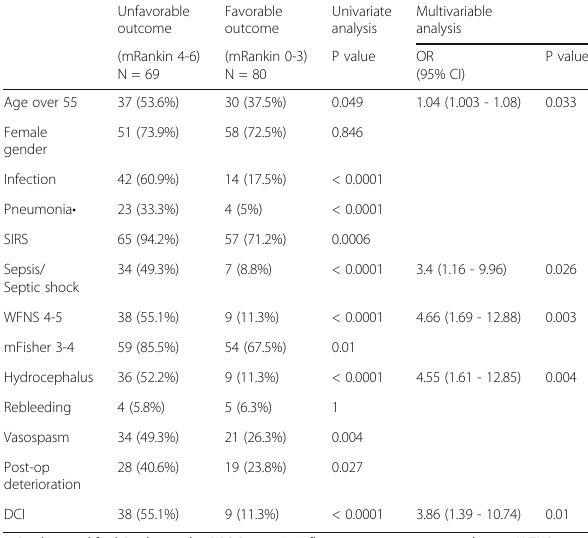
Table 1 (abstract P22). Study variables and association with functional outcome (at